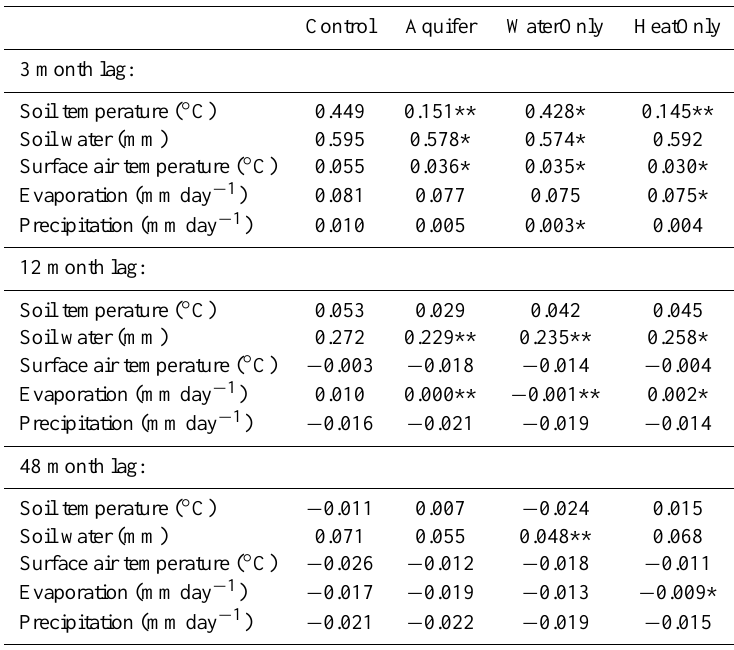
Table 3. Autocorrelation of climate variables at 3, 12, and 48 month